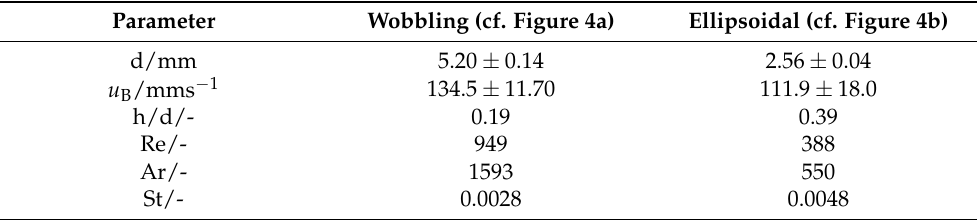
Table 1. Characteristics of the methanol-argon-system for the PIV